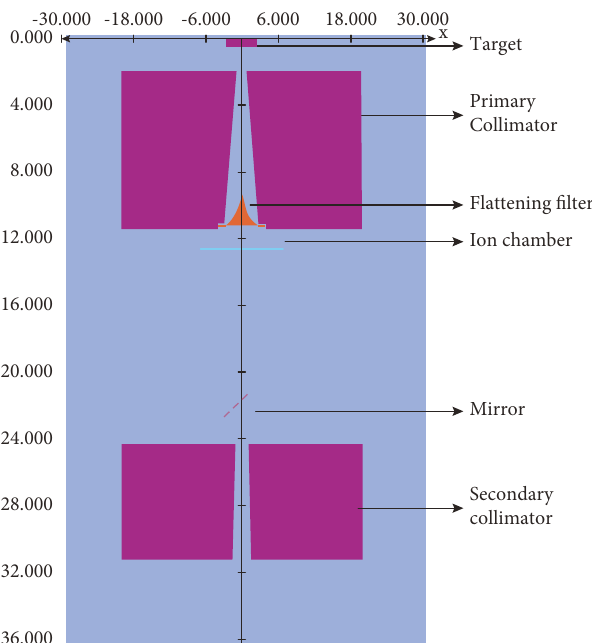
Figure 1: Detailed treatment head structure of XHA600D medical linear accelerator. The units of the numbers on the axes are “cm.” From top to bottom, the components are, in order, target, primary collimator, flattening filter, ion chamber, mirror, and secondary collimator. Phase space files are generated on the scoring plane at z �